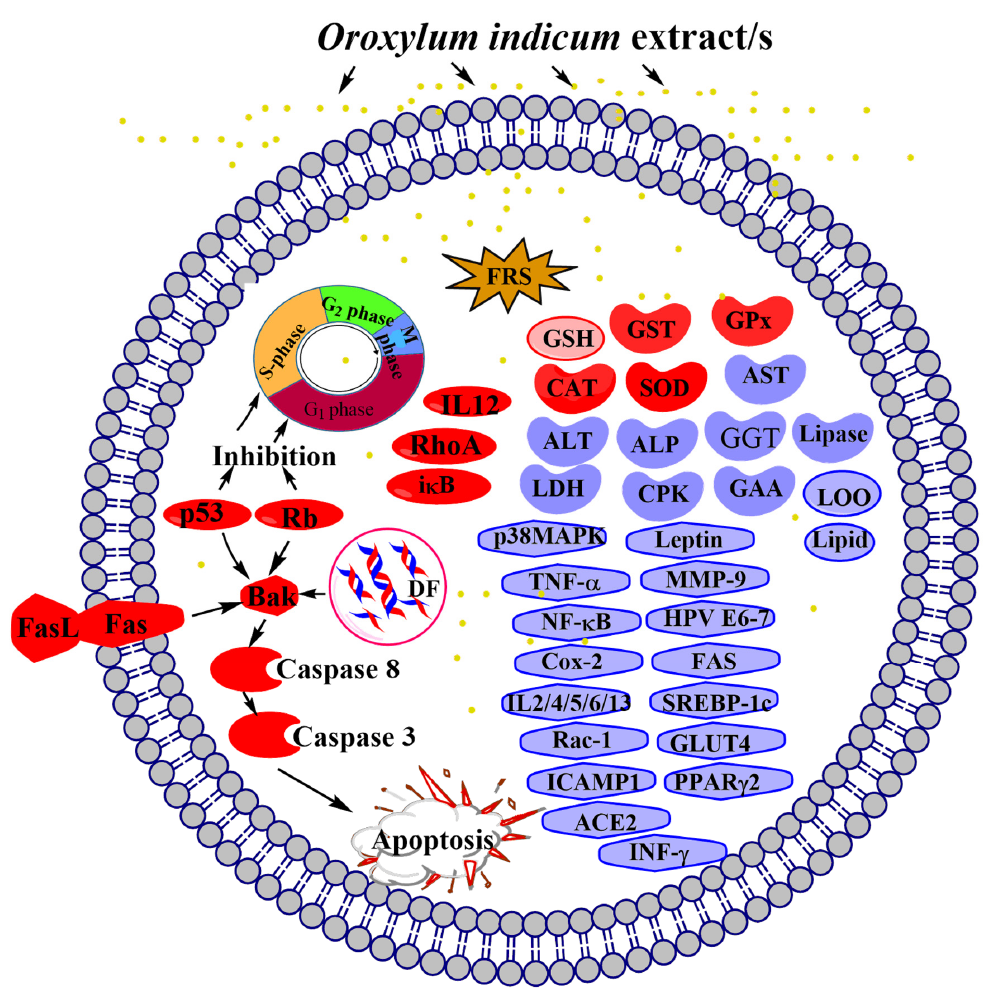
Figure 2. Mechanisms of action of Sonapatha (Oroxylum indicum ). Red: activation/upregulation and blue: downregula- tion/reduction/deactivation.